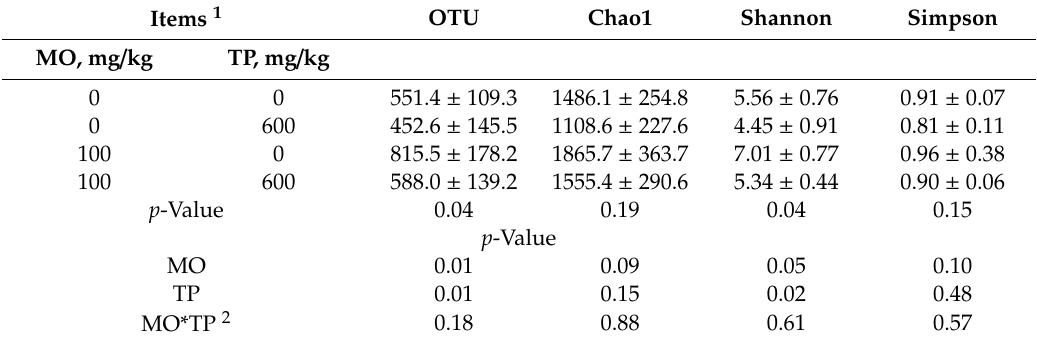
Table 3. E ff ect of molybdenum and tea polyphenols on biodiversity of cecum microbiota of laying hens.